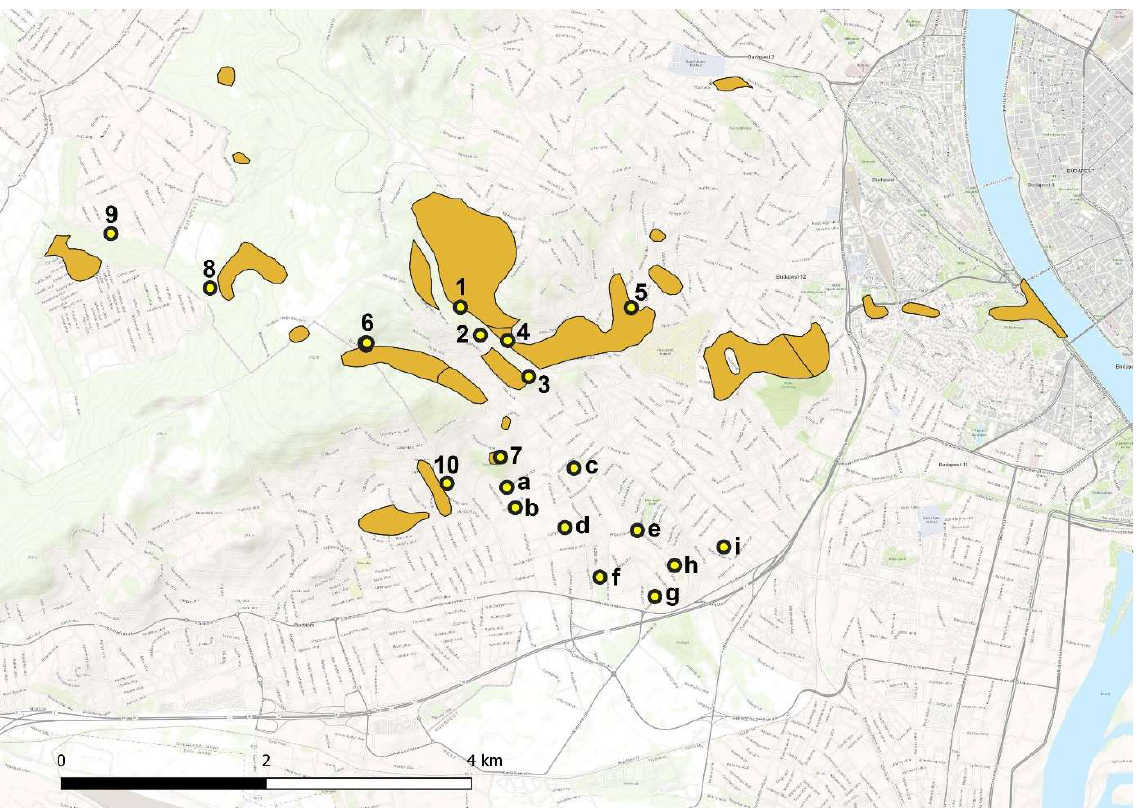
Figure 4. Map of the southern part of the Buda Hills with the geological formations containing Buda hornstone (orange patches), according to the geological map of the Mining and Geological Survey of Hungary (https://map.mbfsz.gov.hu/fdt100/), and the occurrences (yellow circles) already registered into the database of the Institute of Archaeological Sciences of Eötvös Loránd University, Budapest. 1: Farkas-völgy 1; 2: Farkas- völgy 2; 3: Ördög-orom; 4: Edvi Illés utca; 5: Budapest-Farkasrét; 6: Irhás-árok; 7: Rupp-hegy; 8: Végvári- szikla; 9: Budakeszi-Kavics-árok; 10: Budaörs-Tűzkő-hegy; a-i: occurrences recorded during archaeological supervision. (CAD by N. Faragó) Figure 4. Carte de la partie méridionale des monts de Buda avec les formations géologiques contenant de roches siliceuses (tâches oranges), d’après la carte géologique du Service de Minerie et de Géologie de la Hongrie (https://map.mbfsz.gov.hu/fdt100/), et avec les gîtes (cercles jaunes) déjà enregistrés dans la base de données de völgy 2; 3: Ördög-orom; 4: Edvi Illés utca; 5: Budapest-Farkasrét; 6: Irhás-árok; 7: Rupp-hegy; 8: Végvári- szikla; 9: Budakeszi-Kavics-árok; 10: Budaörs-Tűzkő-hegy; a-i: lieux d’apparition documentés durant supervision archéologique. (DAO: N.